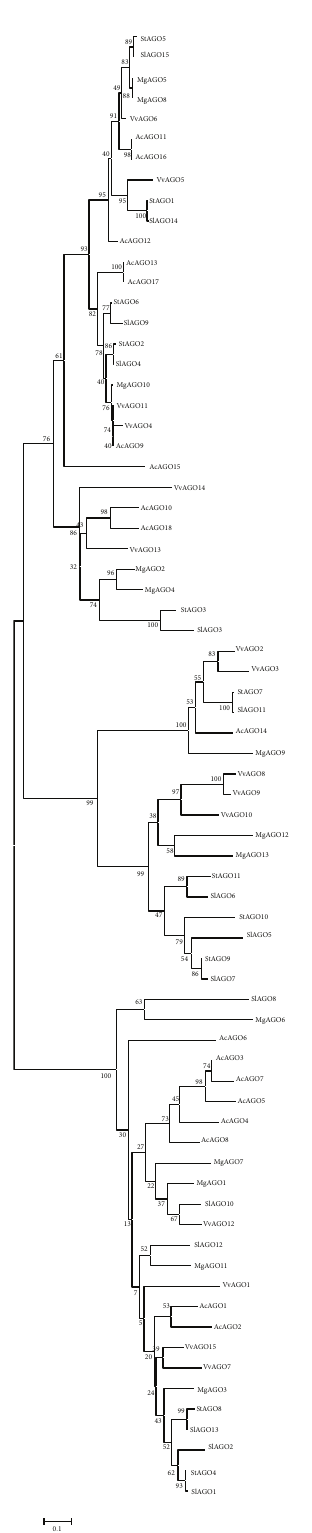
Figure 4: Phylogenetic tree of the Argonaute protein related to Vitis vinifera, Solanum tuberosum, Solanum lycopersicum, Mimulus guttatus, and Aquilegia coerulea plant